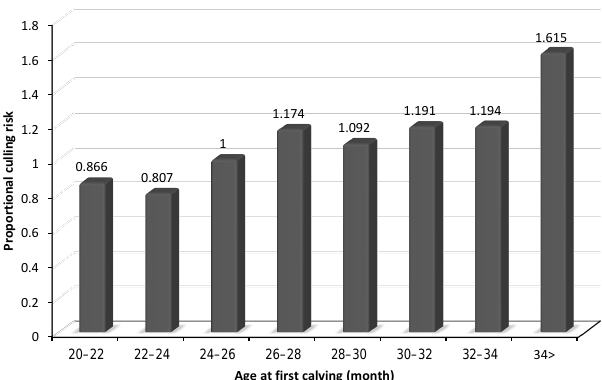
Figure 4. Relationship between age at first calving and proportional culling risk.